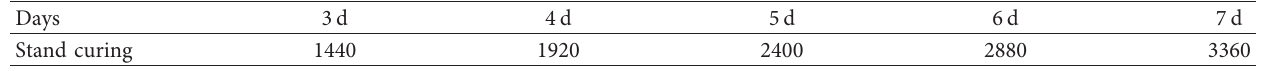
Table 4: The maturity data for the standard curing (Case 1) ( ° C · h).